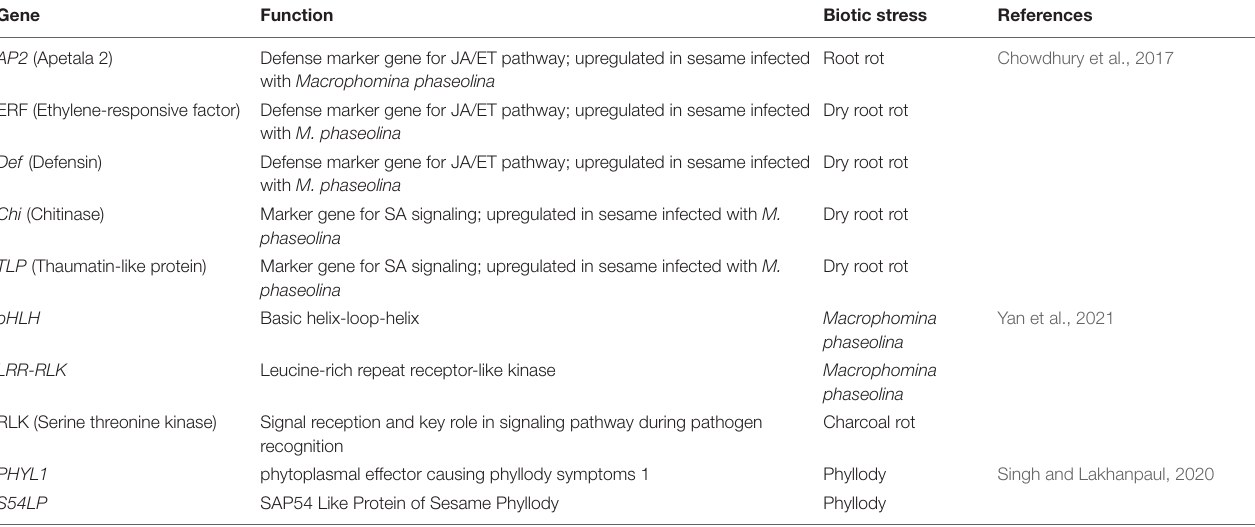
TABLE 8 | Genes associated with biotic stress tolerance in sesame. Gene Function Biotic stress